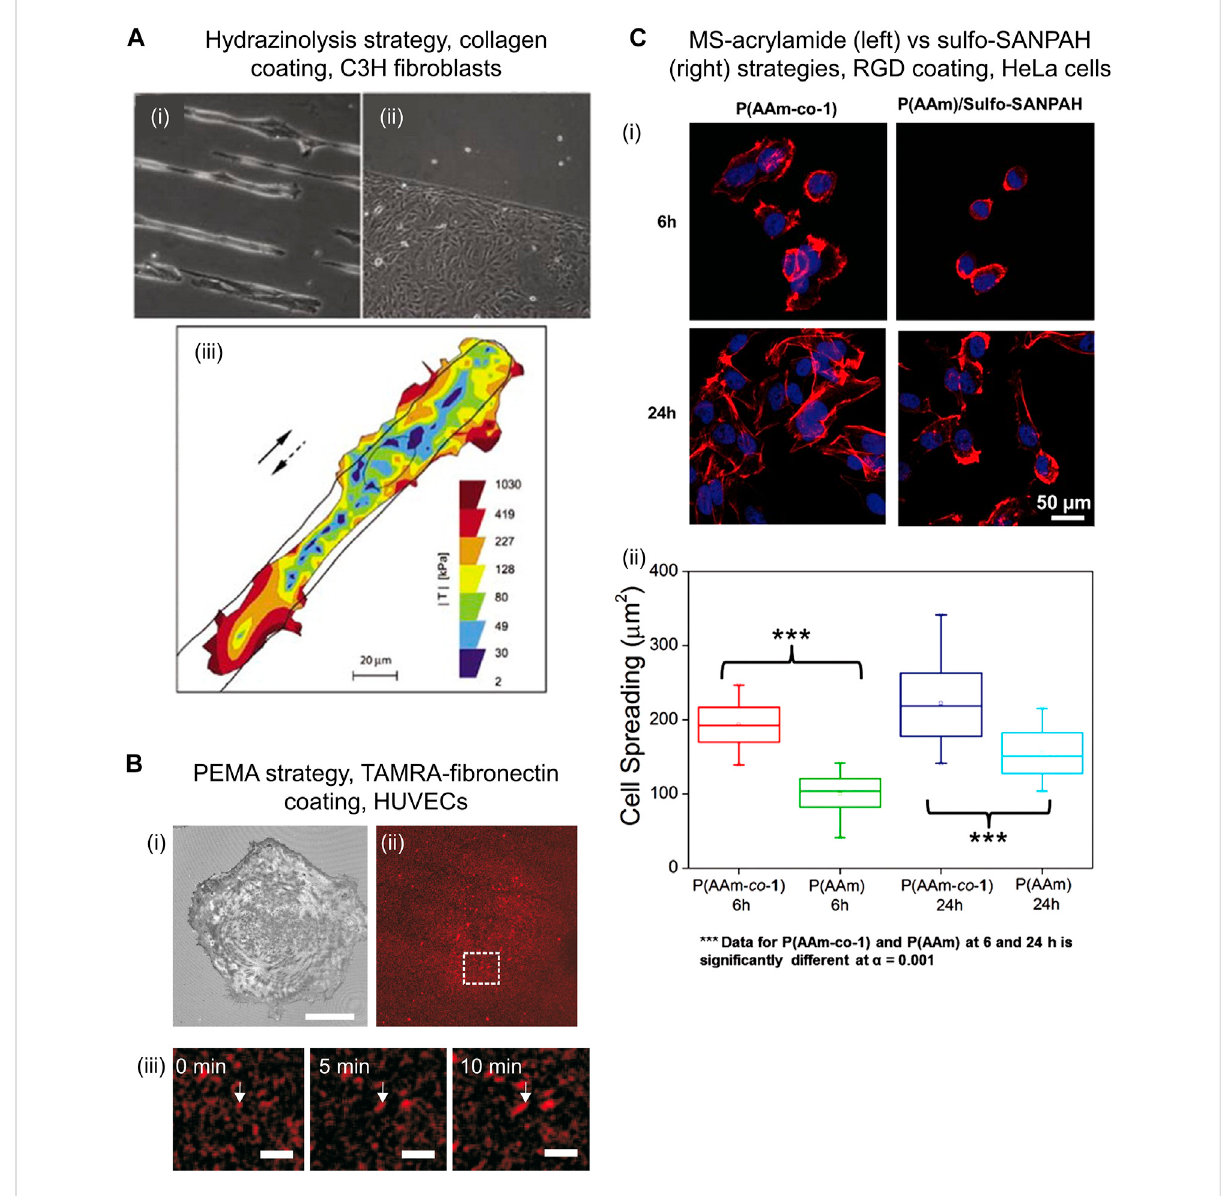
FIGURE 2 Examples of cells cultured on PAM hydrogels that were biofunctionalized through diverse chemical strategies. (A) Bright fi eld images of C3H fi broblasts on PAM gels patterned with collagen I using hydrazinolysis strategy on 15 µm stripes (i) and bottom half part of the image (ii). Cells kept viable after 3 days of seeding. Traction map of C3H fi broblast while moving along a 25 µm wide stripe of collagen I (full and dashed arrows indicate original and reversed direction, respectively) (iii). Reproduced with permission from Ref. (Damljanovic et al., 2005). Copyright 2005 Future Science Ltd. (B) Re fl ection interference contrast microscopy image showing adhered HUVECs after 30 min seeding (i) on PAM gels functionalized with TAMRA- fi bronectin (ii) via PEMA strategy. (Pompe et al., 2011) Scale bar: 30 μ m. In situ analysis of fi bronectin fi brillogenesis shows growing fi bronectin fi bersover time, indicated bywhite arrows(iii). Scalebar: 5 μ m.Reprintedfrom Ref.(Pompeet al.,2011).Copyright2011, with permission fromElsevierLtd. (C) Confocal fl uorescenceimagesshowingHelacellsafterseedingfor6and24 honPAMgelsfunctionalizedwithRGDpeptide via MS-acrylamide (left panel) vs. sulfo-SANPAH (right panel) strategies (i). Cell spreading area on PAM-MS gels was signi fi cantly larger than on sulfo- SANPAH gels, demonstrating effective and chemo-speci fi c ligand immobilization (ii). Reproduced with permission from Ref. (Farrukh et al., 2016). Copyright 2016 John Wiley and Sons,